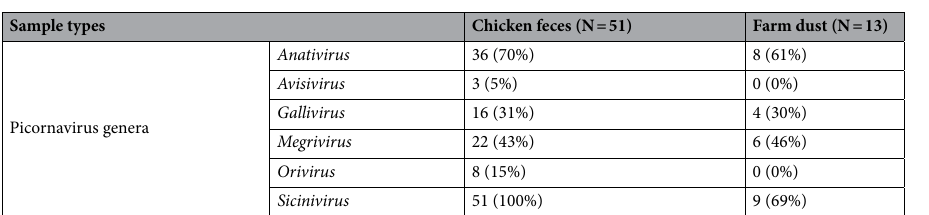
Table 2. Detection of viral sequences from picornavirus genera in chicken feces and farm dust samples. N is the total number of the samples. The value represents the number of viral sequences with minimum amino acid identity of 70%, minimum length of 300 nt and an e-value threshold of 1 × 10 –10 were included. The percentage is the detection percentage of the picornavirus genera in our